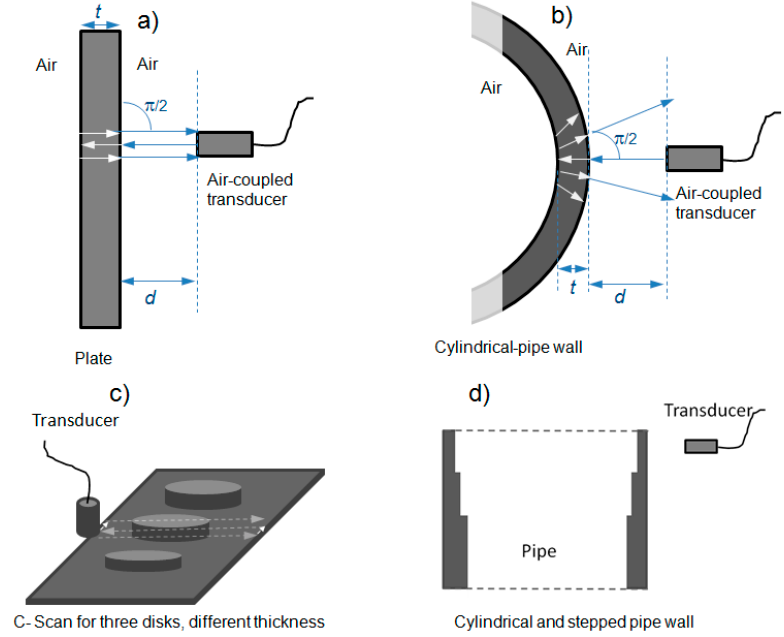
Figure 3. Transducers and sample configurations in pulse measurements: ( a ) plate, ( b ) cylindrical pipe, ( c ) C-Scan of three different steel disks, and ( d ) cylindrical pipe with stepped pipe wall thickness.